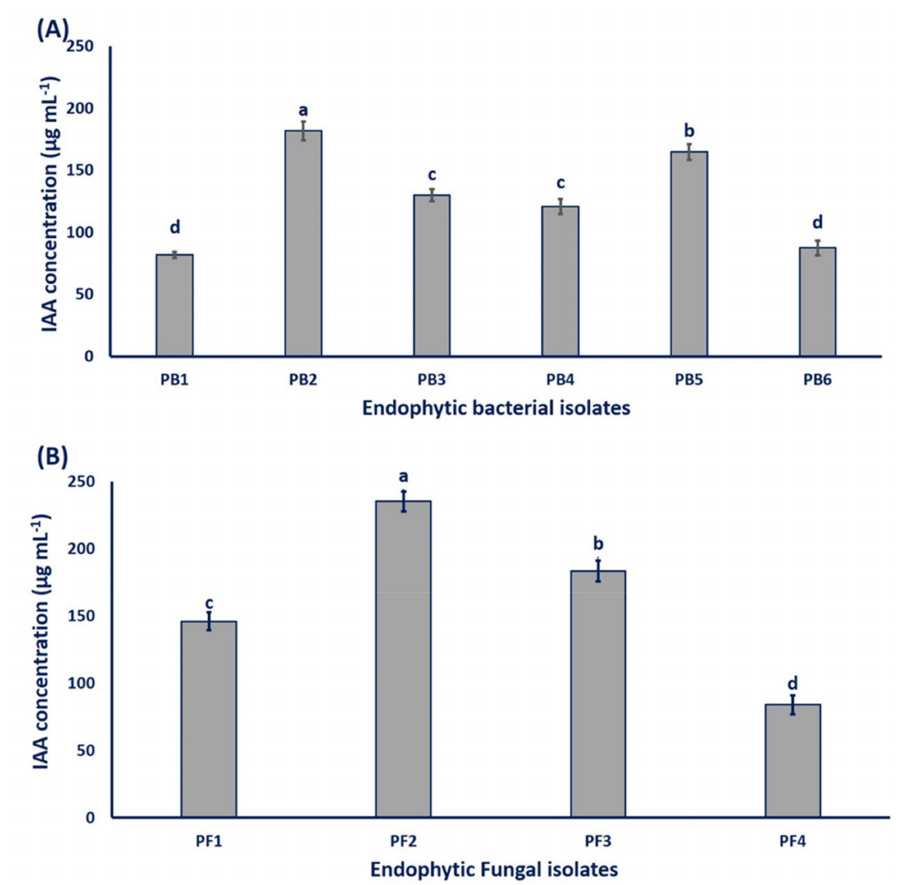
Figure 3. IAA production by ( A ) endophytic bacterial isolates and ( B ) endophytic fungal isolates; with 5 g L − 1 tryptophan. Bars with the same letter for each endophytic isolate did not differ significantly at a significant level of ( p ≤ 0.05); Error bars indicate means ± SE by LSD test ( n = 6). PB1 is E. asburiae; PB2 is B. thuringiensis ; PB3 is A. radioresistens ; PB4 is B. brevis ; PB5 is B. agri ; PB6 is B. subtilis ; PF1 is P. crustosum ; PF2 is A. sorghi ; PF3 is P. commune ; PF4 is A. flavus